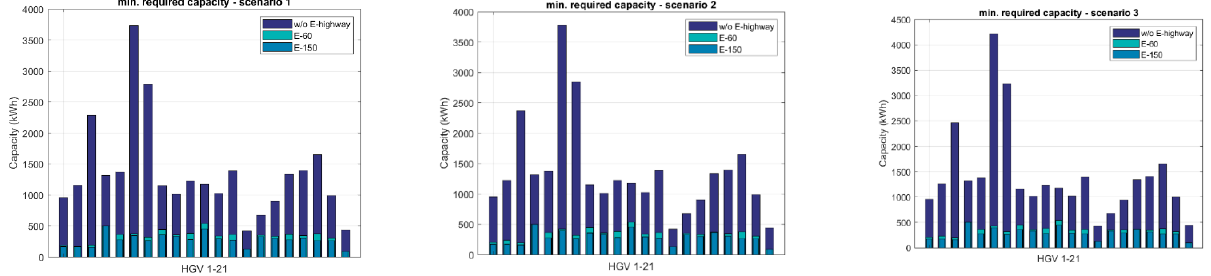
Figure 4. Average consumption of highway and nonhighway routes (own illustration).